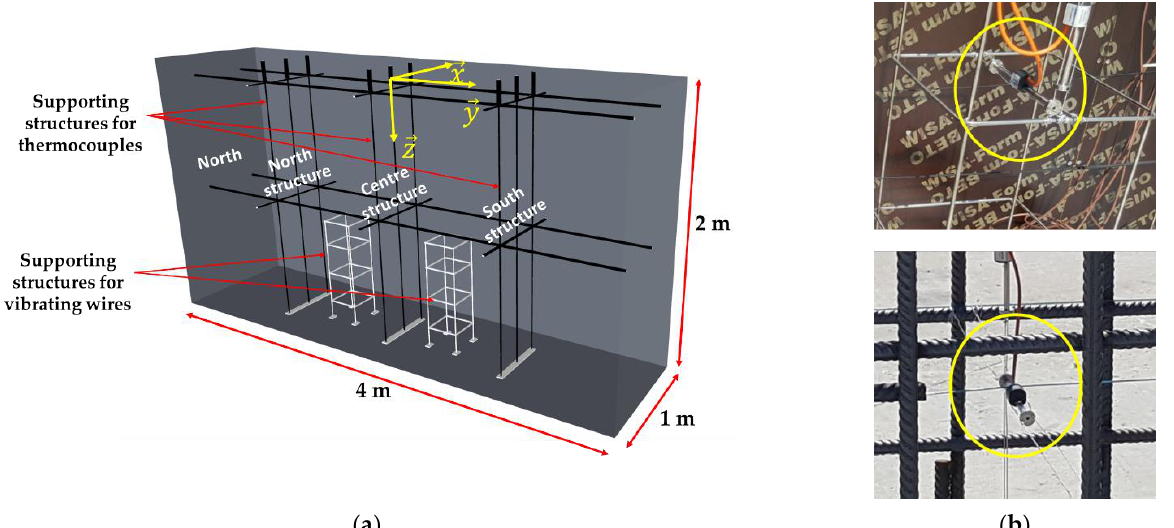
Figure 2. ( a ) Supporting structures for conventional sensors in NRC concrete block; ( b ) Installation of vibrating wires in an NRC block (top) and in an RC block (bottom).